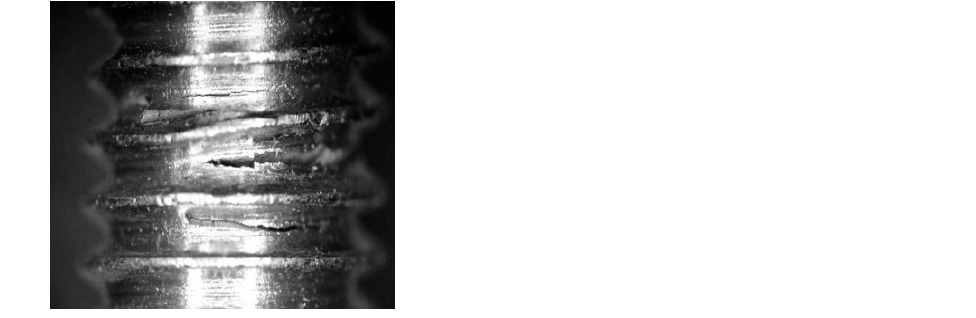
Figure 14. Cracks generated at consecutive thread roots in longer clamp configuration and low load conditions.